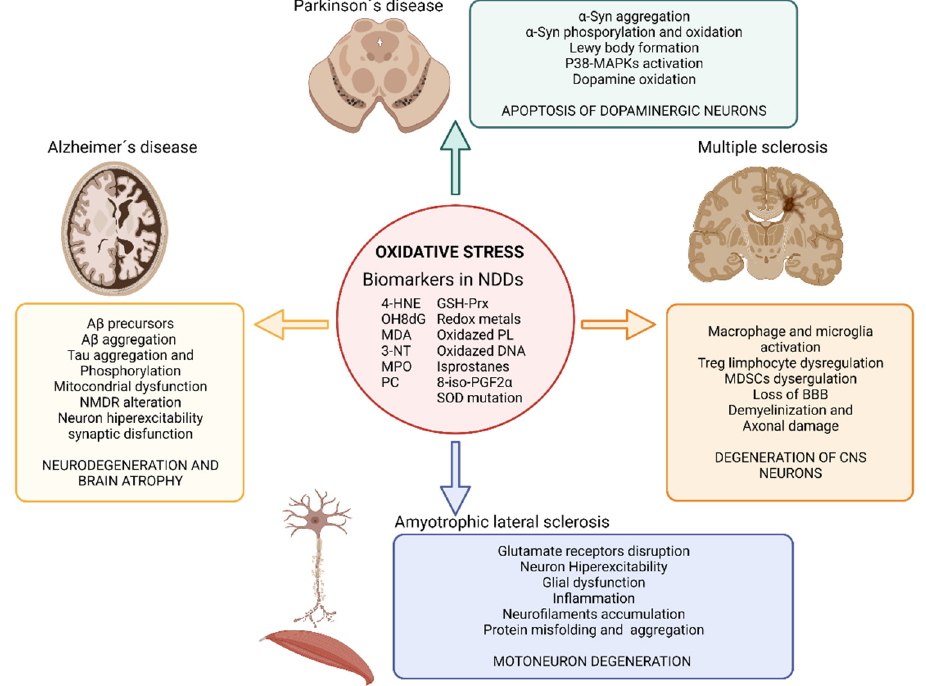
Figure 2. Impact of oxidative stress on neurodegenerative diseases. Illustration showing the impact of oxidative stress on Alzheimer’s disease, Parkinson´s disease, amyotrophic lateral sclerosis and multiple sclerosis and the main biomarkers of oxidative stress found in neurodegenerative disease´s studies. Abbreviatures: BBB, blood brain barrier; GSH-Prx, glutathione-peroxiredoxins; 4-HNE, 4-hidroxinonenal; NDDs, neurodegenerative diseases; NMDR, N-metil-D-aspartato receptors; MDA, malondialdehyde; MAPKs, Mitogen-activated protein kinases; MPO, Myeloperoxidase; 3-NT, 3-nitrotyrosine; OH8dG, 8-hydroxy-2 ′ -deoxyguanosine; PC, protein carbonyl; 8-iso-PGF2 α ,8-iso-prostaglandin F2 α ; α -Syn, α -Synuclein; SOD, superoxide dismutase. Created with BioRender.com [12].